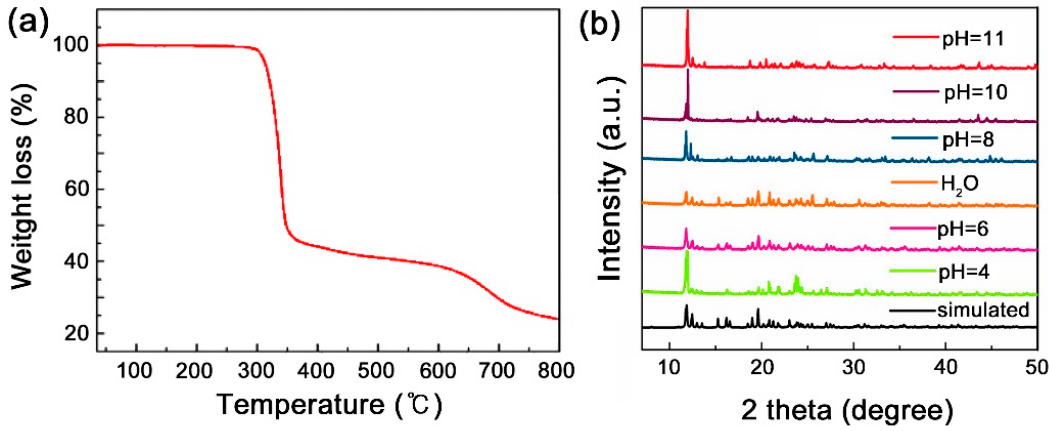
Figure 7. ( a ) Thermal gravity analysis graph of Cd-MOF and ( b ) PXRD spectrum of Cd-MOF neglected in various pH aqueous solution and water for 24 h. Reproduced and adapted from Ref. [54]; Copyright (2019), RSC Analyst.